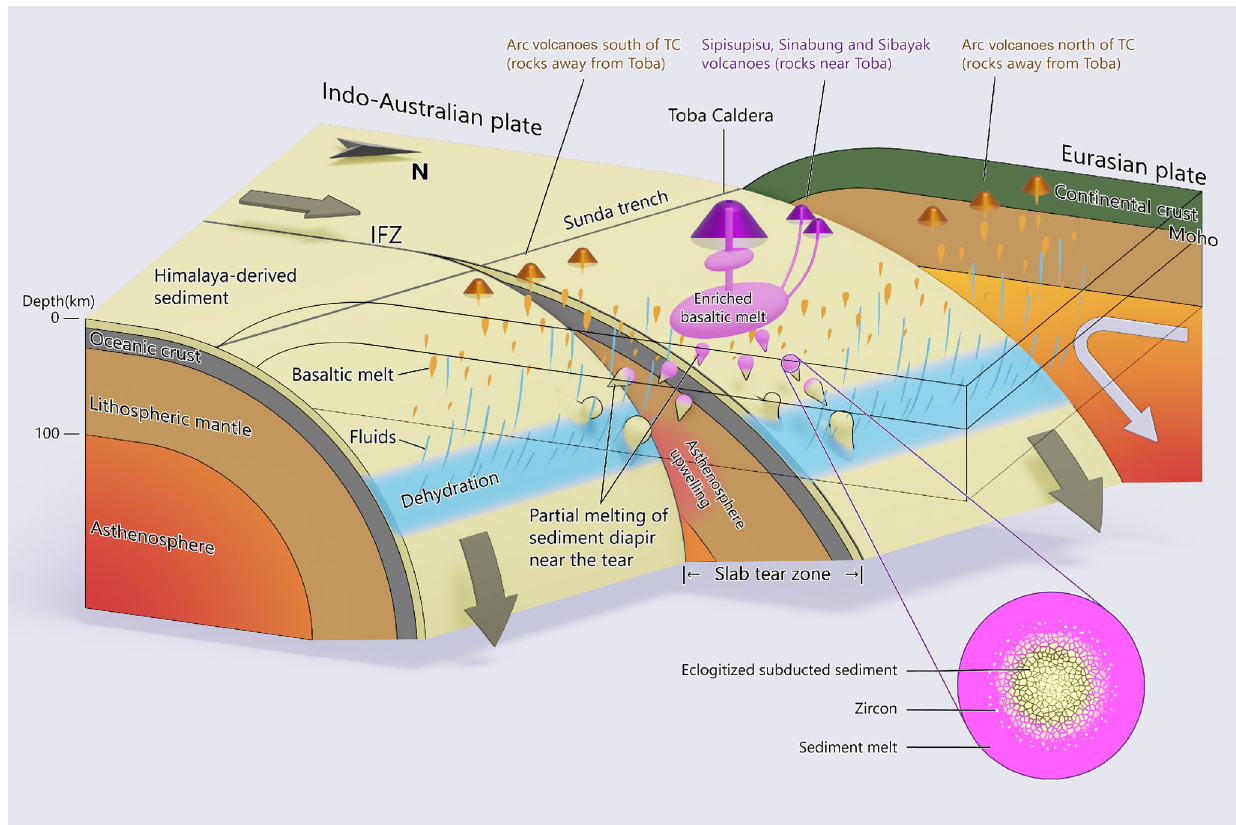
Fig. 8 3D scenograph illustrating the model of Indian Ocean fl oor subduction and sediment diapirs under northern Sumatra. Oblique subduction of the Investigator Fracture Zone (IFZ) resulted in a slab tear beneath the Toba Caldera (TC). The subducted sediments at ~150 km depth around the slab tear area have undergone diapirism followed by partial melting within the hot corner of the mantle wedge, which generated geochemically enriched arc volcanic rocks with inherited zircons from the sediments in the vicinity of the Toba Caldera (rocks near Toba). Farther away from the IFZ, dehydration of the subducting plate and fl ux melting of the mantle wedge were the dominant processes responsible for the depleted mantle-like Sr and Nd isotopes of the rocks away from Toba. A zoom-in view of sediment melting with some undissolved zircon grains is shown in the bottom right